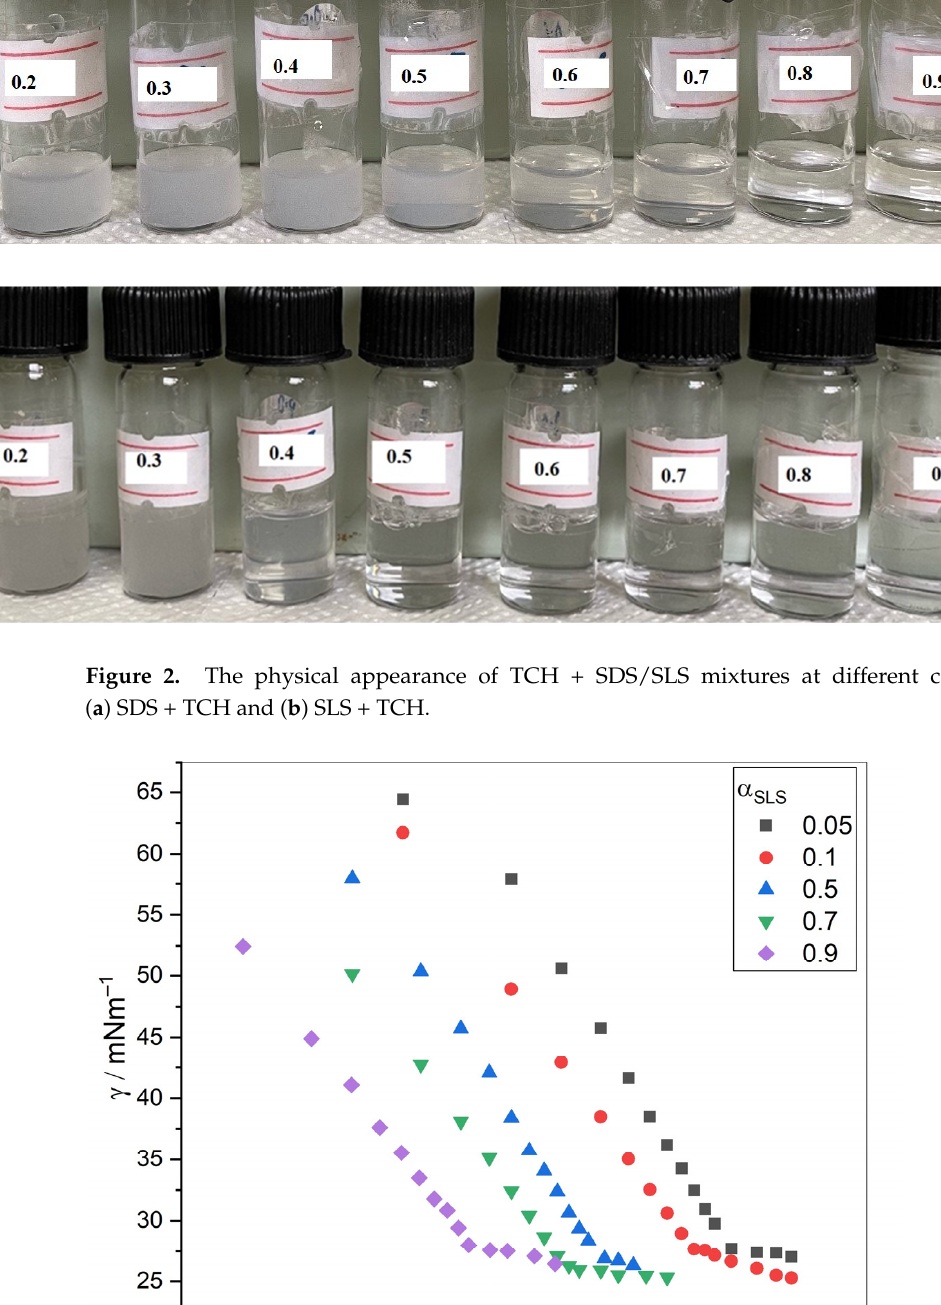
Figure 3. Graph of surface tension versus log molar concentration for SLS + TCH mixed systems.